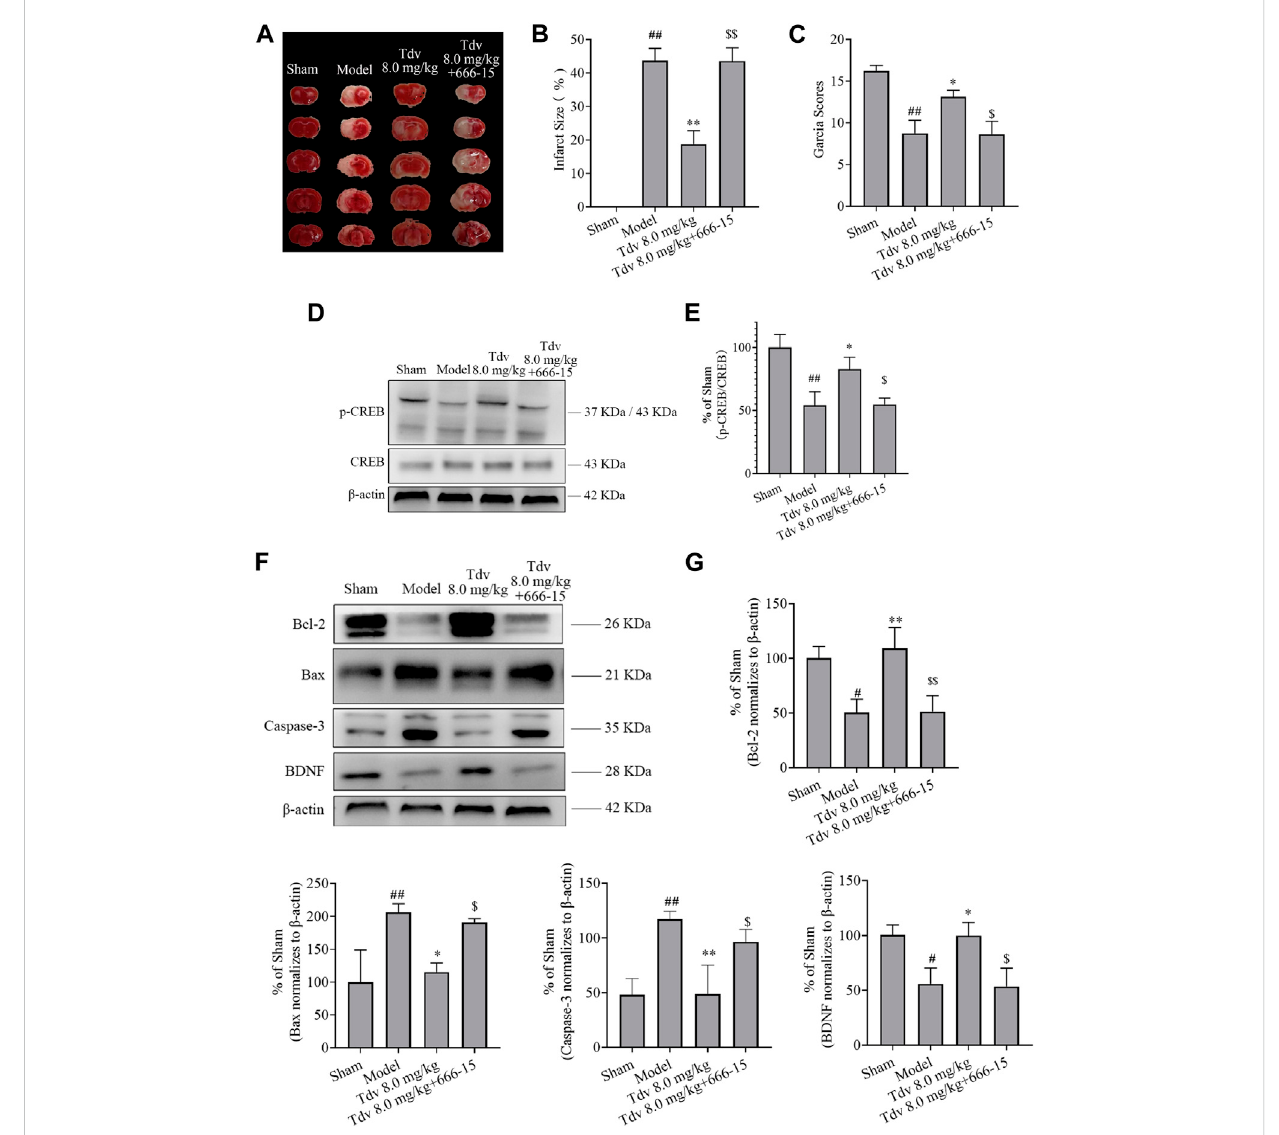
CREBinhibitorreversedtheneuroprotectiveeffectsoftoludesvenlafaxine. (A) TTCstaining; (B) Cerebralinfarctsize(n=8); (C) GarciaScores(n=8); (D) The expression of p-CREB; (E) Western blotresults of p-CREB (n = 3); (F) The expressionofBDNFand anti-apoptotic protein; (G) Westernblotresults of BDNF and anti-apoptotic protein (n = 3). # p < 0.05, ## p < 0.01 versus sham; * p < 0.05, ** p < 0.01 versus model; $ p < 0.05, $$ p < 0.01 versus